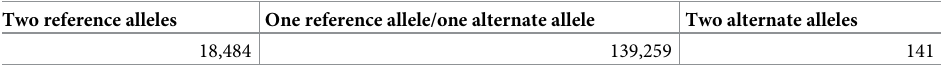
Table 2. Number of loci in Pyr_27, when Pyr_1 locus carries two reference alleles and Pyr_19 locus carries two alternate alleles.